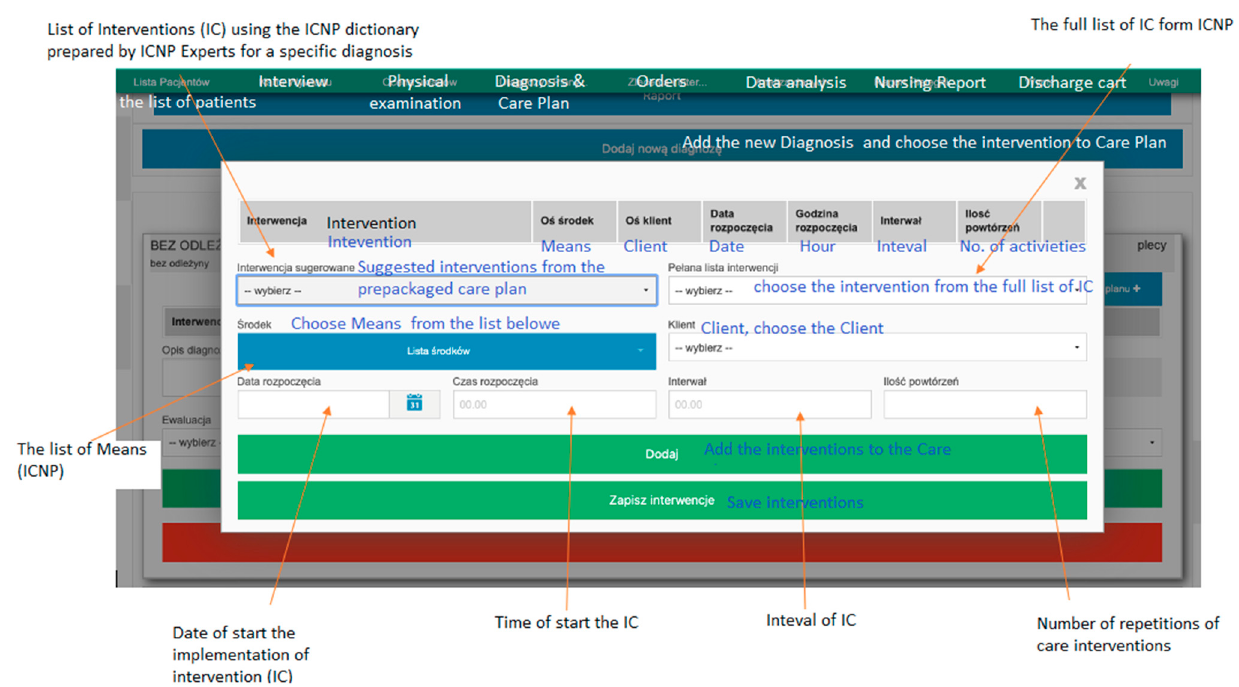
Figure 1. ICNP clinical support system “ADPIECare Dorothea” with care plan window, Available online: http://ciitt.umed.pl/system-dokumentacji-i-wsparcia-prac-pielegniarskich-adpiecare-dorothea/ (accessed on 9 January 2022).